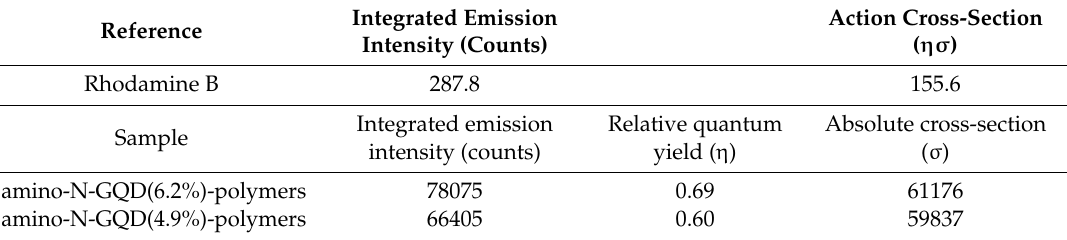
Table 1. TPE cross section of nanomaterials at an excitation wavelength of 800 nm a